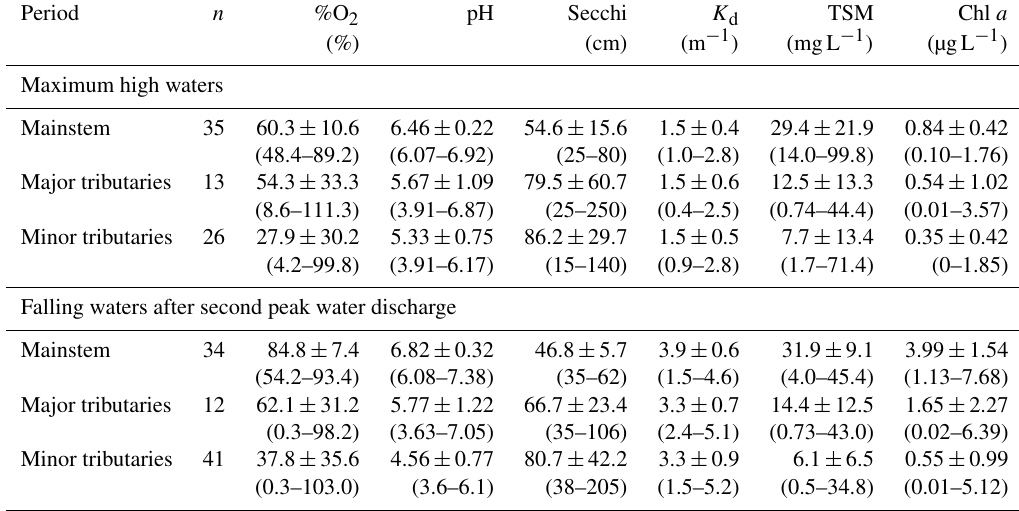
Table 1. Selected attributes (mean ± standard deviation, min–max) of sampling sites during the field campaigns: oxygen saturation level (%O 2 ) , pH, Secchi depth, vertical light attenuation coefficient ( K d ) , total suspended matter (TSM) and chlorophyll a (Chl a ) concentrations (data from Descy et al.,